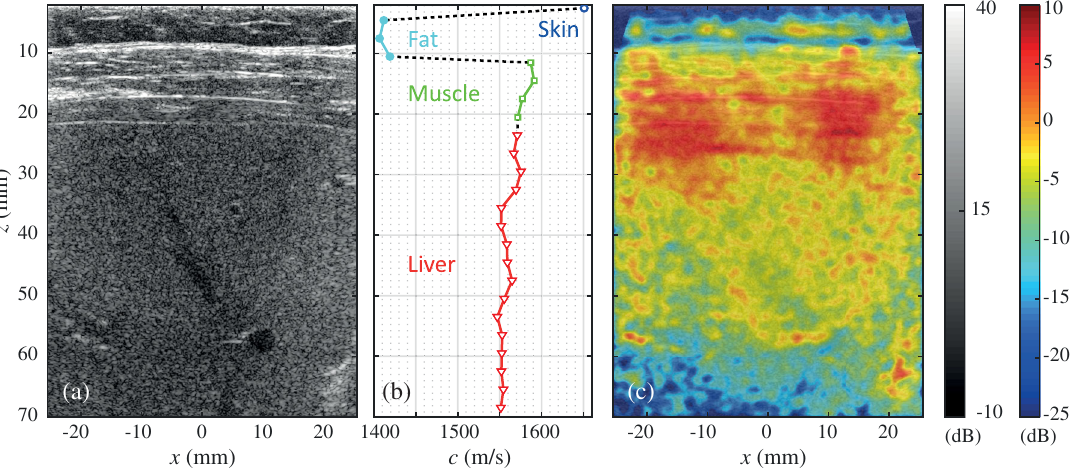
FIG. 6. In vivo imaging of a human liver using the focused reflection matrix approach. (a) Ultrasound image calculated using a four- layer model [Eq. (10)]. The four layers can be identified as skin, fat, muscle, and liver tissue. (b) The speed of sound is calculated for each depth via the optimization of F (Sec. III A). (c) The ratio quantity ϵ ð r Þ is shown in the same region of interest as